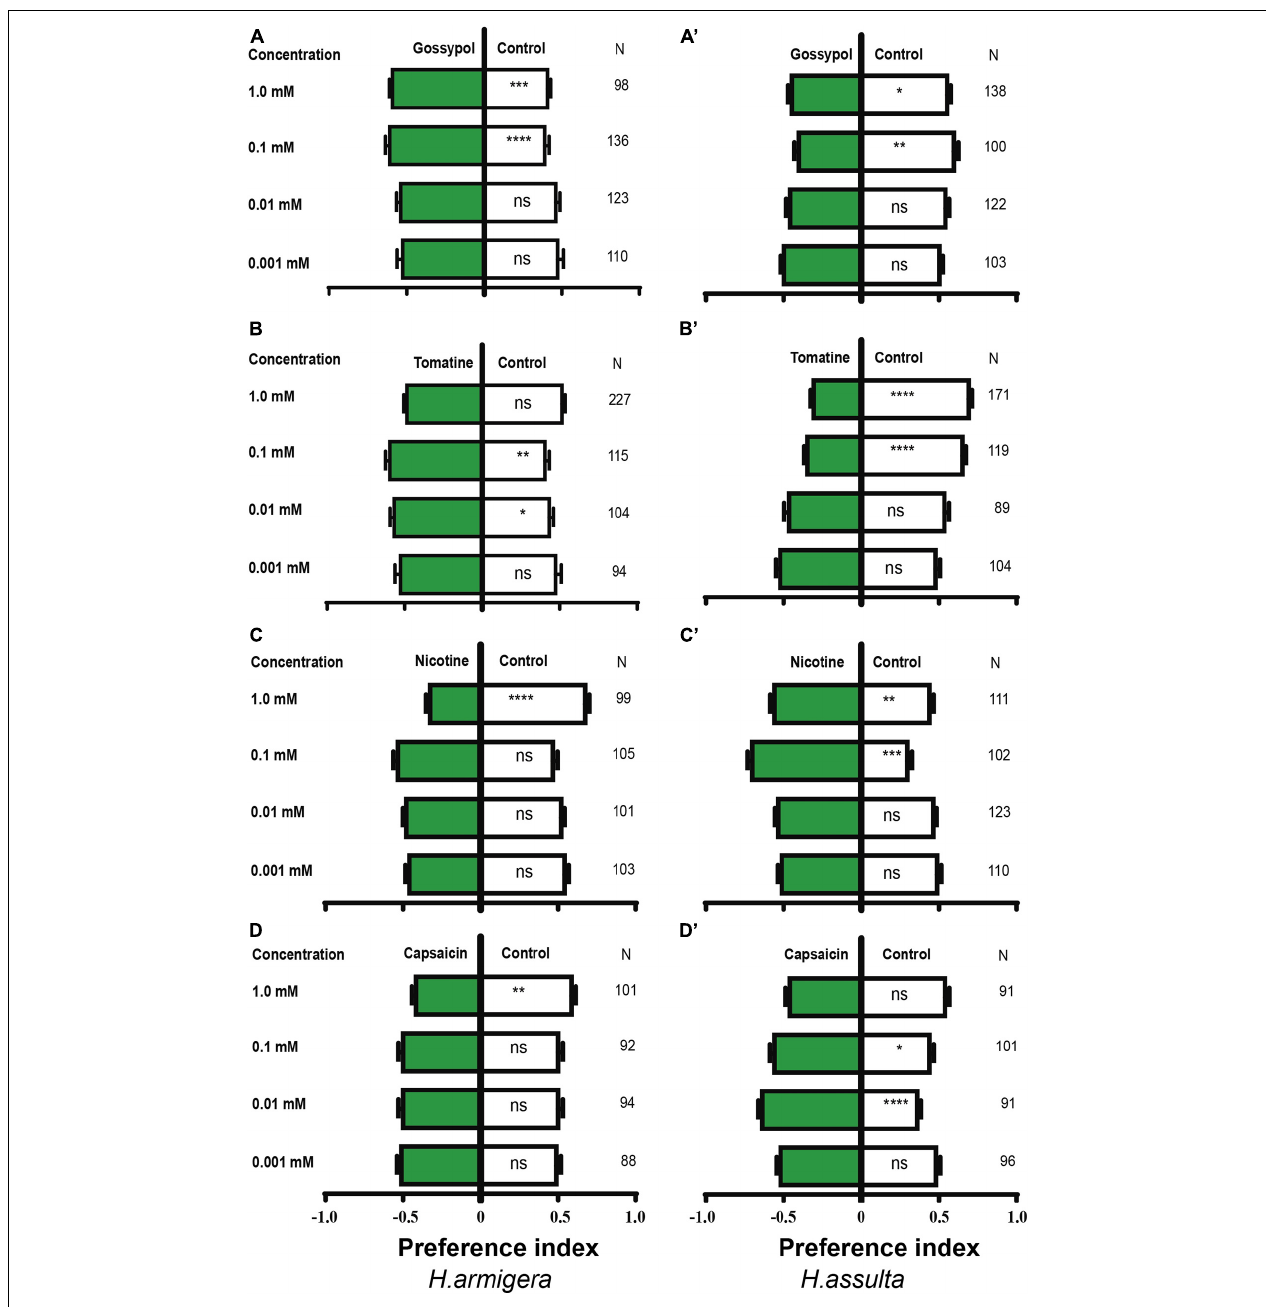
FIGURE 10 | Effects of secondary metabolites on the feeding preferences of Helicoverpa caterpillars. The preference indexes of caterpillars for control leaves (white bar) and for secondary metabolites treated leaves (green bars) were compared by using the paired-sample t -test. The dual-choice assay was used to test the feeding preference for pepper leaves treated by secondary metabolites at different concentrations and for control (electrolyte-treated) leaves. Electrolyte in (A,A’,B,B’,C,C’) was solvent I (0.25% methanol, 5% ethanol, and 0.32% PVP in water). Electrolyte in (D,D’) was solvent II (0.16% PVP in water). (A–D) : H. armigera caterpillars; (A’–D’) : H. assulta caterpillars. “*,” “**,” “***,” and “****” represent that the difference was significant at the 0.05, 0.01, 0.001, and 0.0001 level, respectively. ns: non-significant difference. N: the number of tested